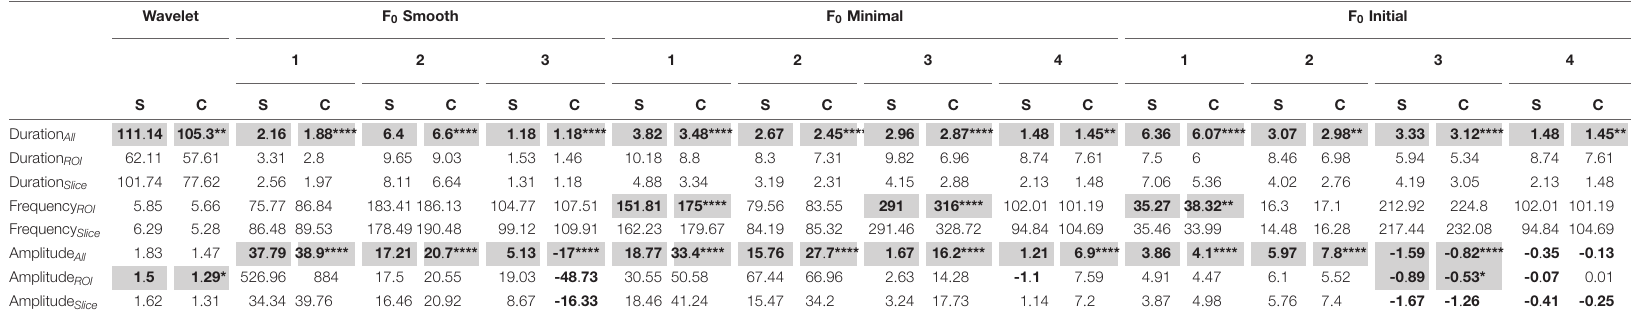
TABLE 2 | Mean values of astrocytic calcium event measures found using each of the tested methods.